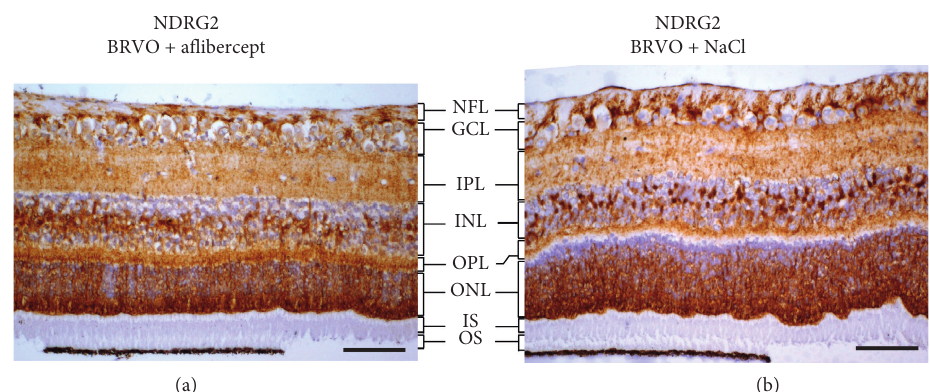
Figure 4: (a) and (b), immunohistochemistry showed a slight downregulation of NDRG2 in the retinal ganglion cell layer and the inner nuclear layer following aflibercept intervention in BRVO. Scale bar � 31 µ m. Reaction color: brown. ILM: inner limiting membrane; NFL: nerve fiber layer; GCL: ganglion cell layer; IPL: inner plexiform layer; INL: inner nuclear layer; OPL: outer plexiform layer; ONL: outer nuclear layer; IS: inner segment; OS: outer